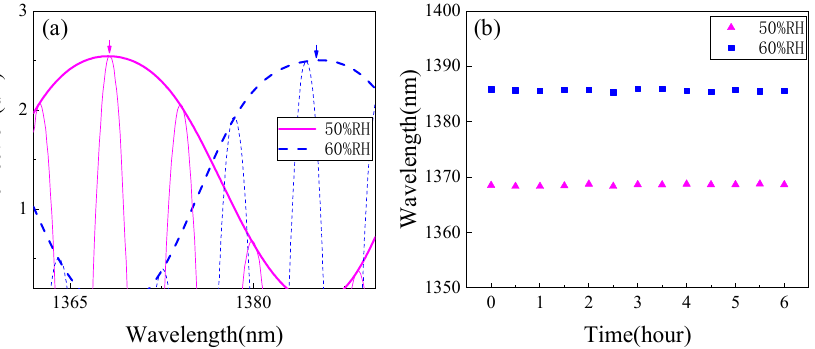
Figure 11. Stability experiment results. ( a ) Spectra at 50% RH and 60% RH and ( b ) stability test results.